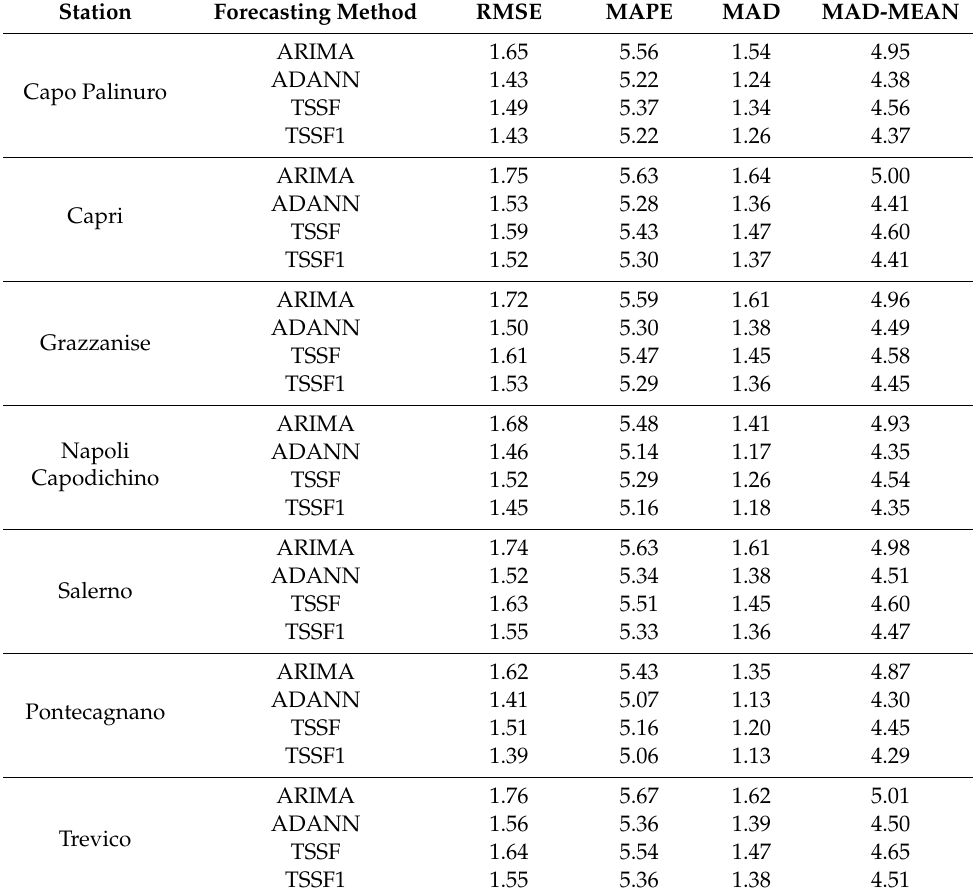
Table 2. Accuracy measures for HI index time series from all the weather station datasets obtained by using ARIMA, ADANN, TSSF, and